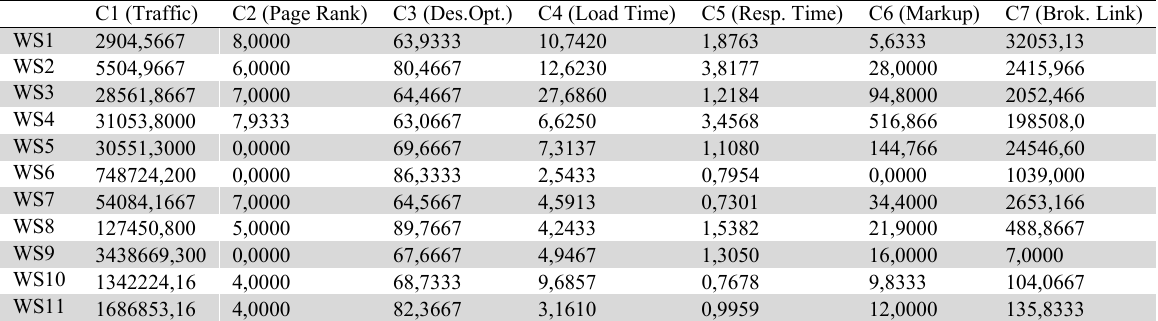
Decision Matrix